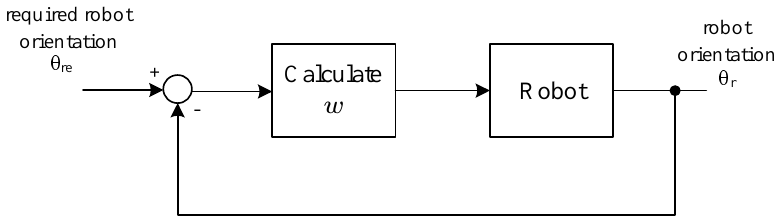
Figure 12. Feedback control diagram for mudskipper-inspired